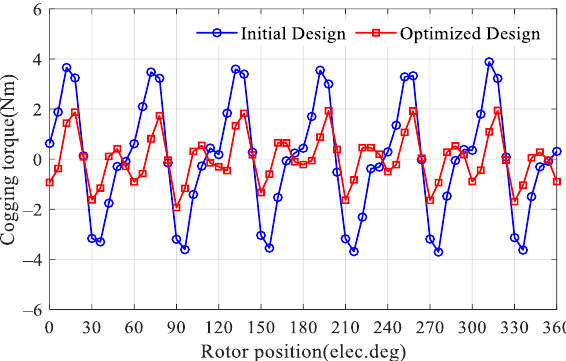
Figure 10. Cogging torque comparisons of the initial and optimized machines.